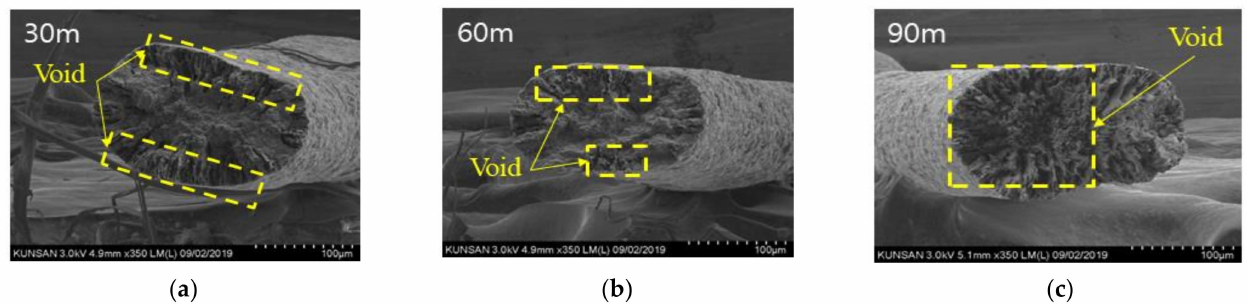
Figure 7. SEM images of the cross section for the initial condition. ( a ) Specimen 30 m; ( b ) Specimen 60 m; ( c ) Specimen 90